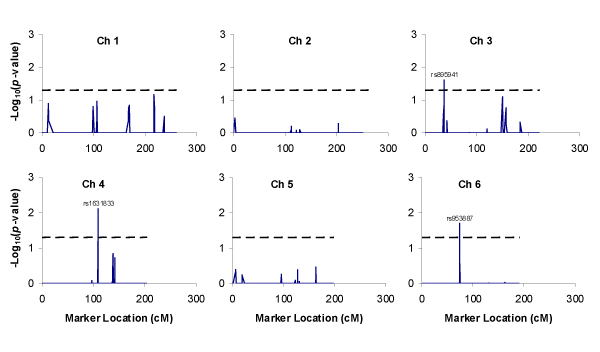
HSC analysis of DSM4 alcohol dependence on chromosomes 1–6 in 93 nuclear family. Horizontal dashed line is the threshold of chromosome-wide 0.05 significance level with line length equals to chromosome length, and three markers with statistical significances exceeding the threshold are labeled with their marker names.